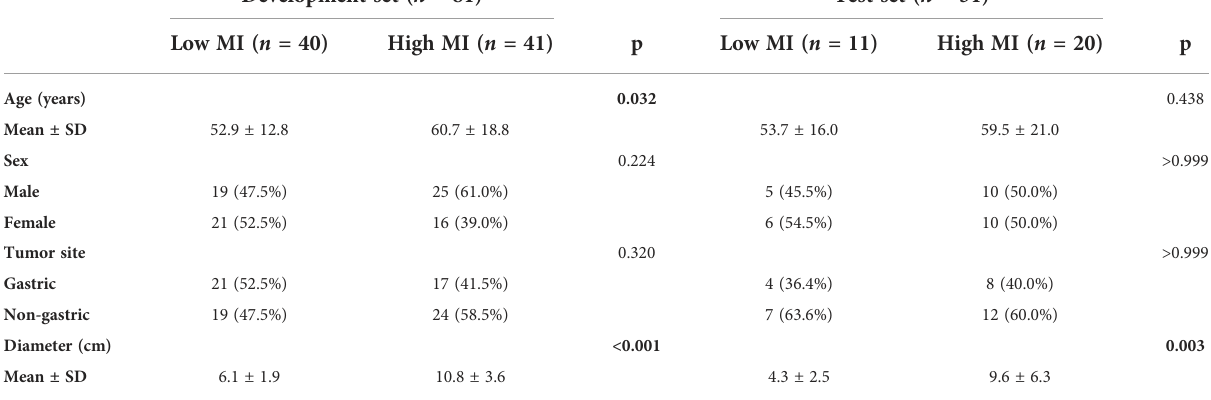
TABLE 2 Patient characteristics.